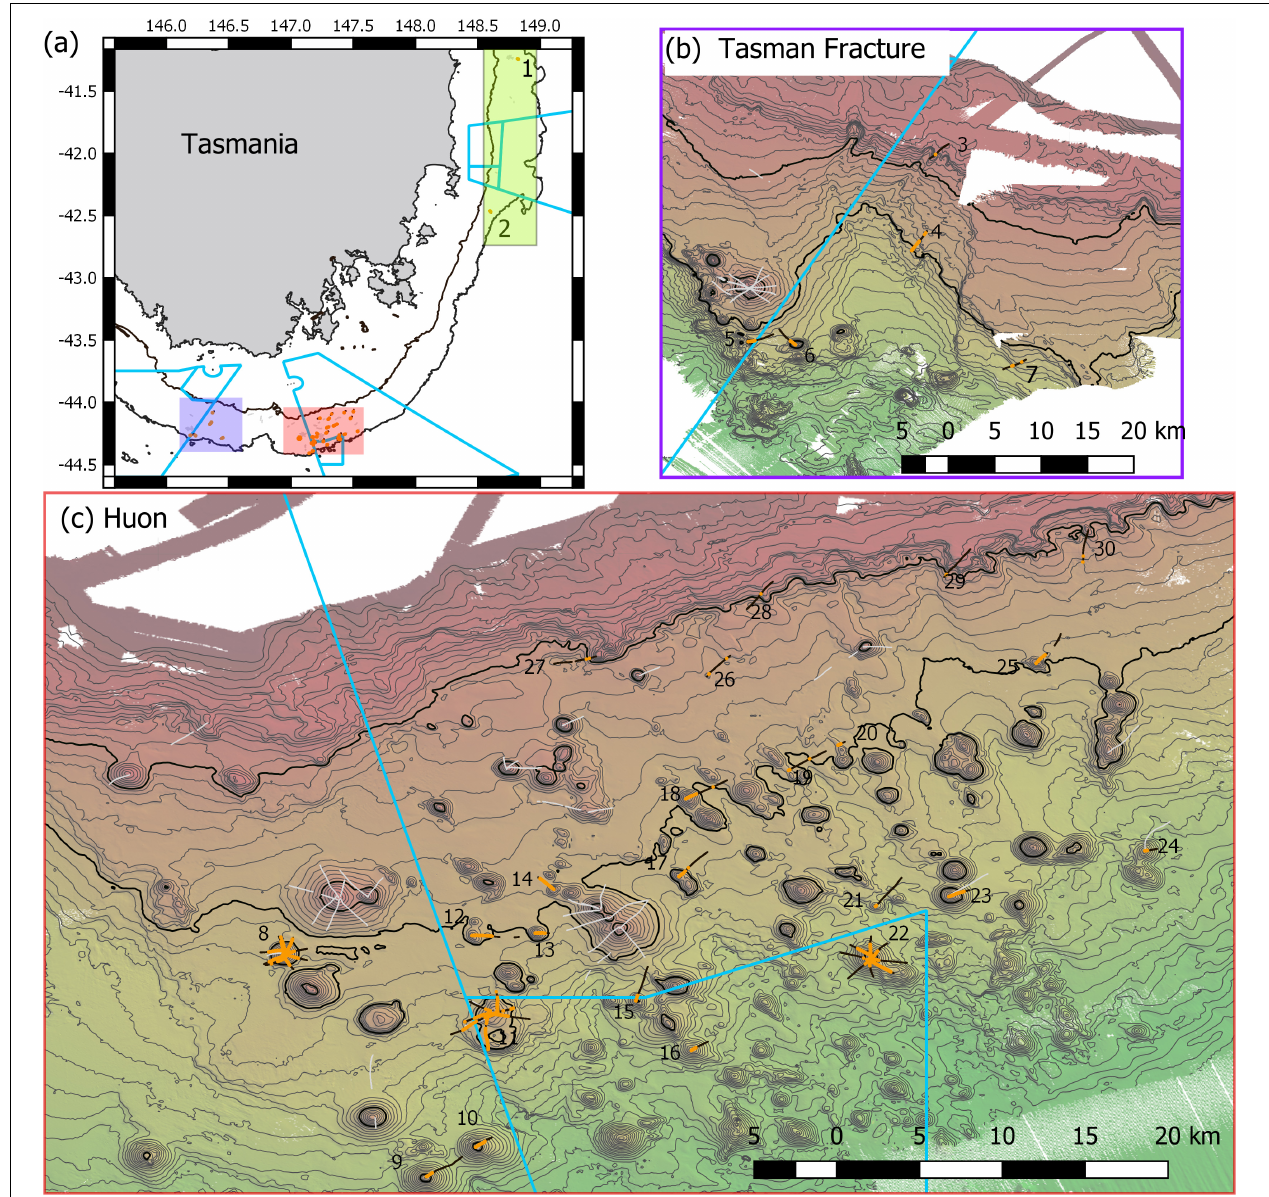
FIGURE 1 | Maps of Tasmanian Seamounts survey area showing locations of the 30 transect sites sampled: (a) overview map showing east coast sub-area (green shaded box; sites 1 and 2) and south coast sub-areas – orange and mauve boxes; (b) south coast Tasman Fracture sub-region (sites 3–7); (c) south coast Huon sub-region (sites 8–30). Photographic transects (black lines) with distribution of the stony coral Solenosmilia variabilis matrix (live and dead) overlaid (orange); transects with fishing impacts eliminated from analysis (gray lines). Boundaries of Australian Marine Parks (blue lines); Depth contours: panel (a) 250 and 2000 m – define the limits of the survey area; panels (b,c) 50 m intervals with 950 and 1350 lines